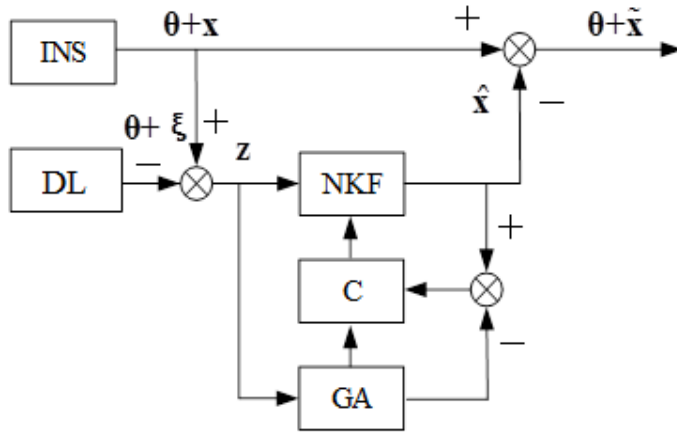
Figure 1. Scheme of inertial navigation system (INS) correction by genetic algorithm (GA).